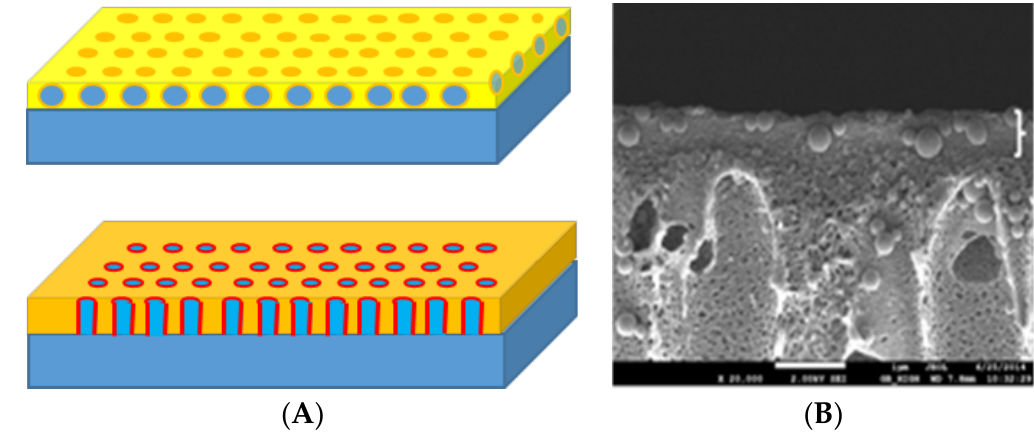
Figure 1. Two popular design concepts for biomimetic separation membranes [13]: ( A top ) a matrix of vesicles with reconstituted aquaporin proteins embedded in an immobilizing material (yellow) (e.g., polyamide) constitutes the selective layer formed on top of a substrate layer (blue) (e.g., polysulfone). ( A bottom ) a monolayer with the protein (red) directly embedded in a host membrane (orange) formed on top of a substrate layer (blue). ( B ) scanning electron micrograph of the design in ( A ). Scale bar 1 µ m. The design in ( A top ) have also recently been used for creating membranes based on immobilized imidazole quartets [15].